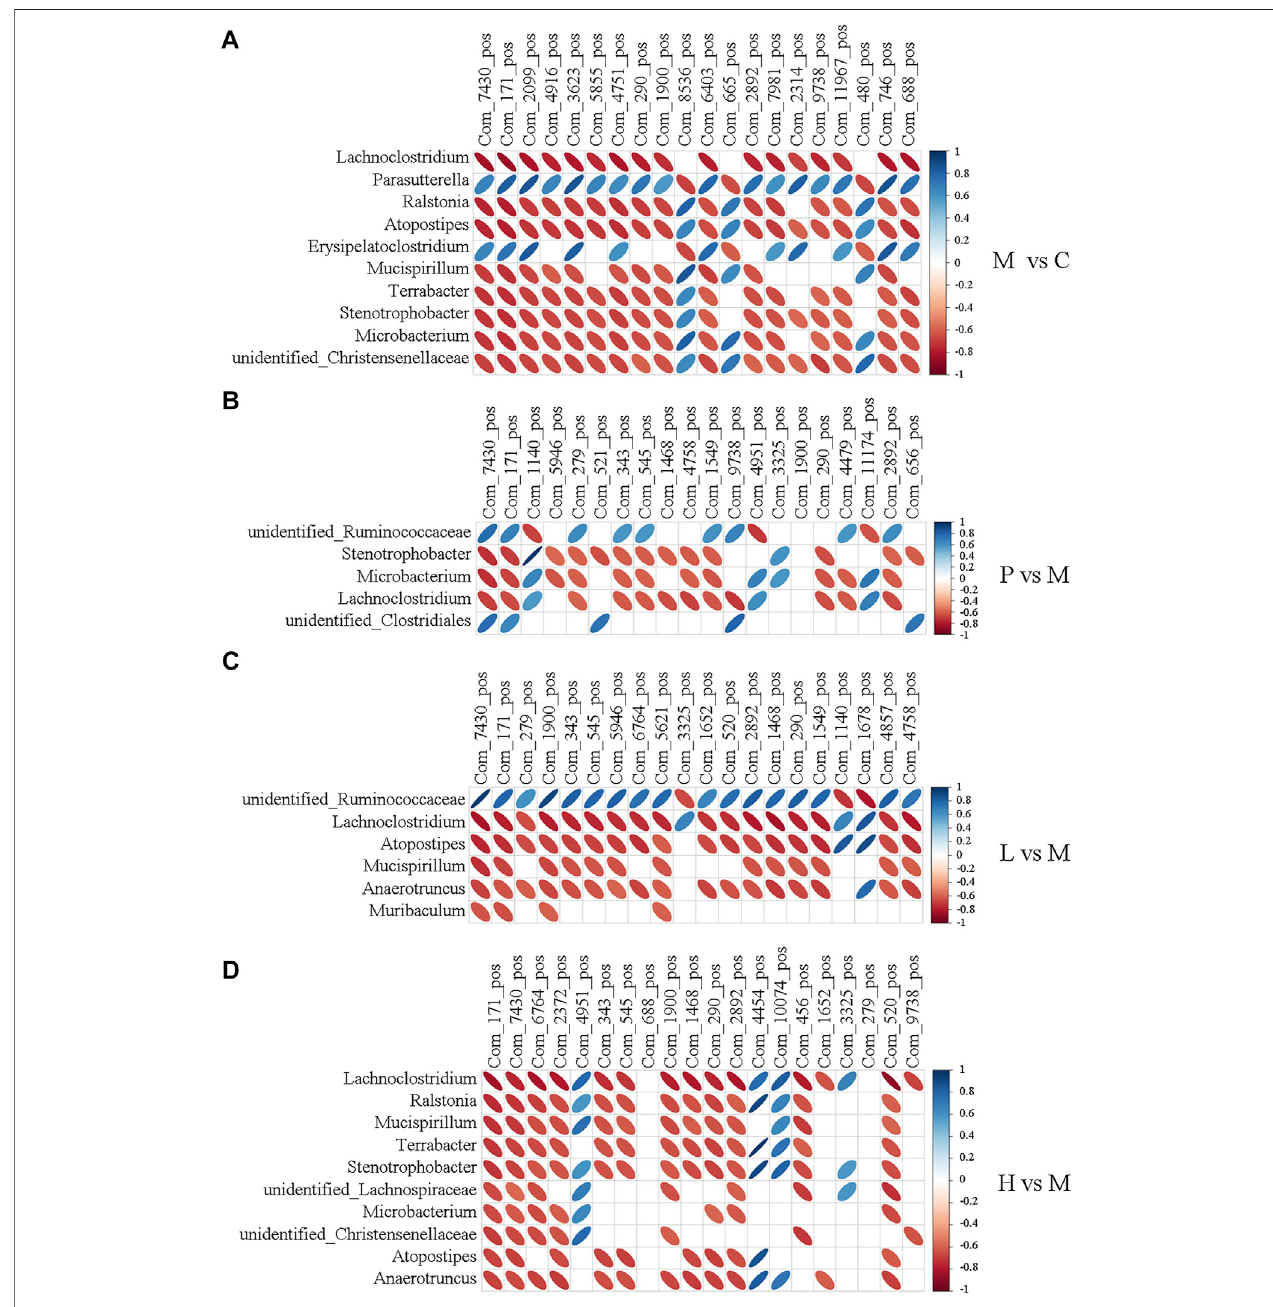
FIGURE 6 | Heatmap describing the correlation analysis of relative abundance of gut microbiota in the genus level and liver metabolite levels under the positive ion mode. (A) Mvs.C; (B) Pvs.M; (C) Lvs.M;and (D) Hvs.M.Thehorizontalaxisshowsthetop20ofthedifferentialmetabolitesinthecomparisonpair,theleftverticalaxis shows the differential bacteria, and the right means the correlation coef fi cient. Blue indicates positive correlation and red indicates negative correlation.